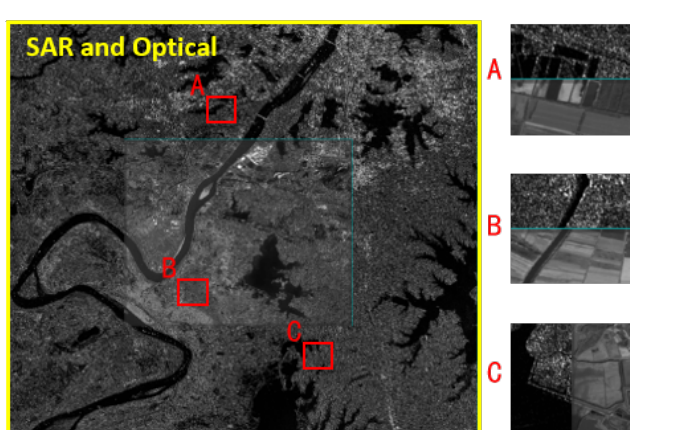
Figure 11. The pair A.